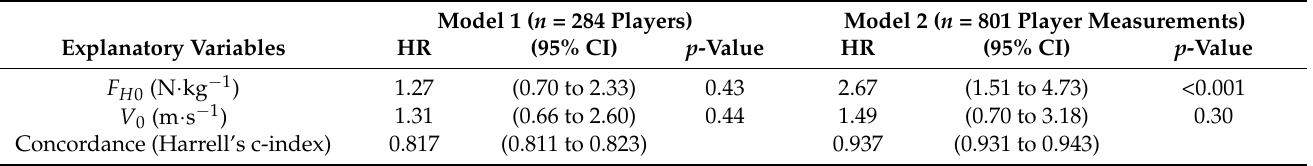
Table 2. Hazard ratio (HR) with 95% confidence interval (95% CI) of the association between F H 0 and V 0 ; and (1) new hamstring injury during the season based on F H 0 and V 0 values at the start of the season for the 284 players and adjusted for group, age, height, body mass, and history of hamstring injury (model 1); and (2) new hamstring injury after the sprint acceleration measurement based on the F H 0 and V 0 values of each measurement of the season for 801 player-measurements and adjusted for individual player, group, age, height, body mass, and history of hamstring injury (model 2), according to the time scale of cumulative hours of